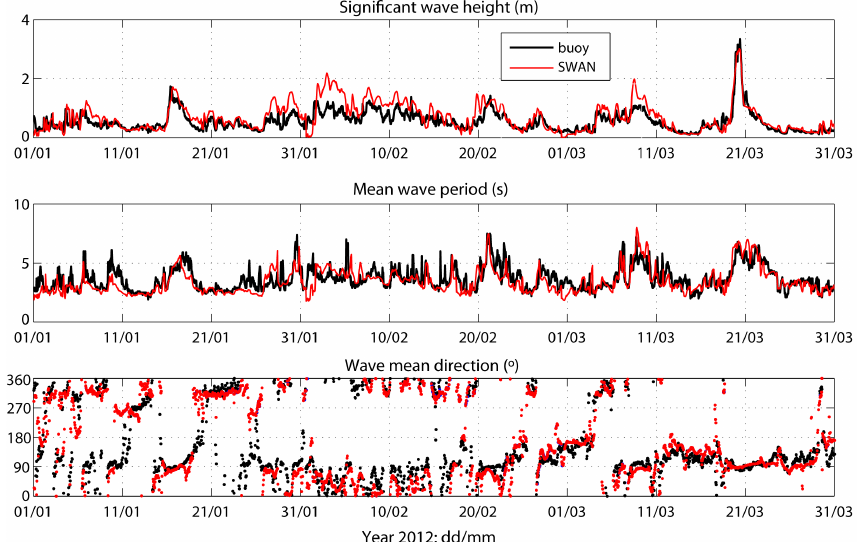
Figure 6. Time series of the significant wave height (m), the mean wave period Tm 01 (s) and the mean wave direction for the first trimester of 2012. In black the buoy measurement is represented and in red the SWAN numerical